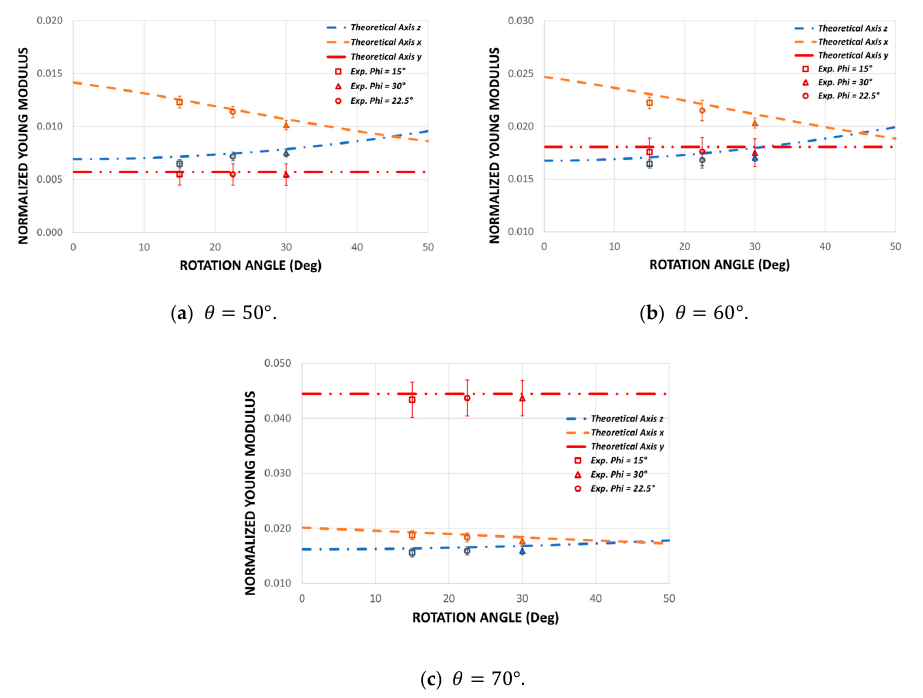
Figure 11. Comparison of the theoretical Young’s modulus E i / E s vs. the experimental Young’s modulus for different values of the re-entrant angle θ = { 50 ◦ ;60 ◦ ;70 ◦ } and for different values of the design parameter ∅